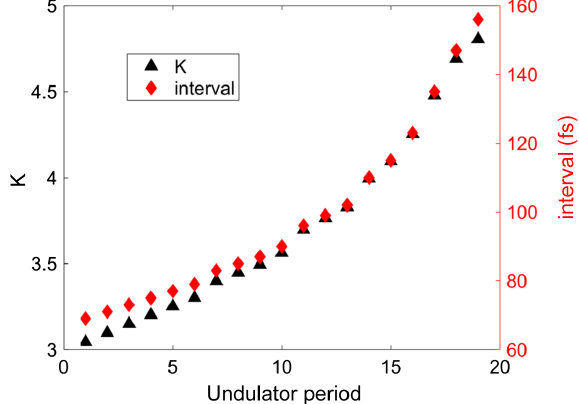
FIG. 6. K value of the n th period of the tapered undulator, which is calculated based on the intervals between adjacent